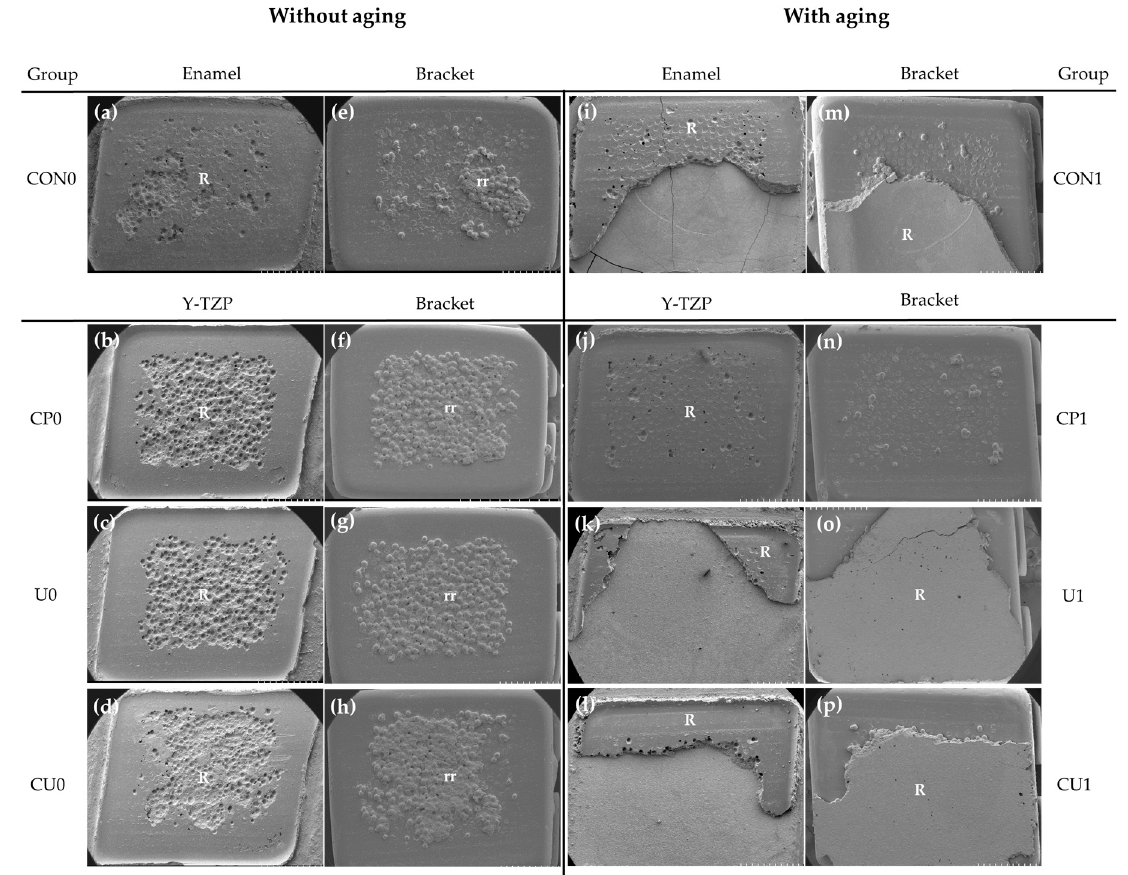
Figure 5. Images of failure interface (×30) without- and with aging: ( a , i ) enamel surface; ( b – d , j – l ) Y-TZP surface; ( e – h ) and ( m – p ) debonded bracket surface. Abbreviations: R, resin; rr, resin captured by retentive beads of bracket.